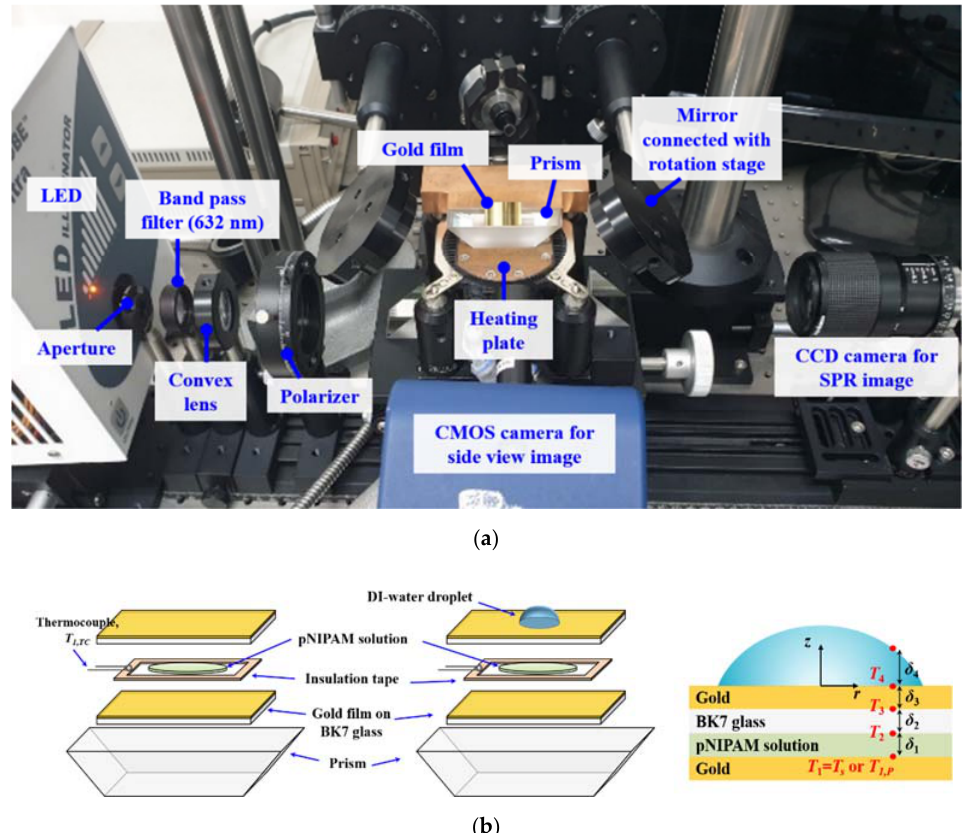
Figure 1. ( a ) Picture of the present surface plasmon resonance imaging (SPRi) experimental setup and ( b ) schematic of temperature measurement using a poly( N -isopropylacrylamide) (pNIPAM) solution, left: for the evaluation of pNIPAM solution, center: droplet temperature measurement, right: cross-sectional schematic of multi-layer.